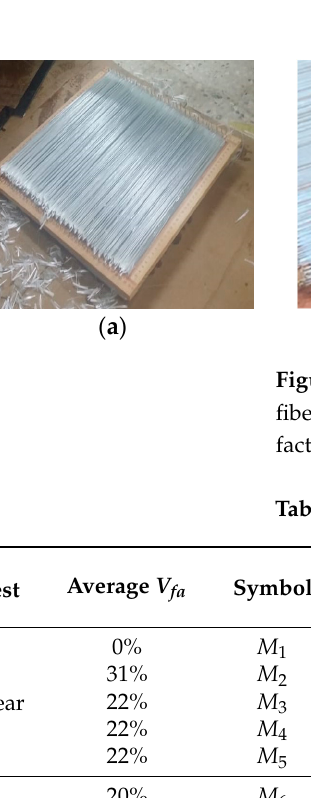
Table 2. The layers’ V f values for the different specimens with average V fa .